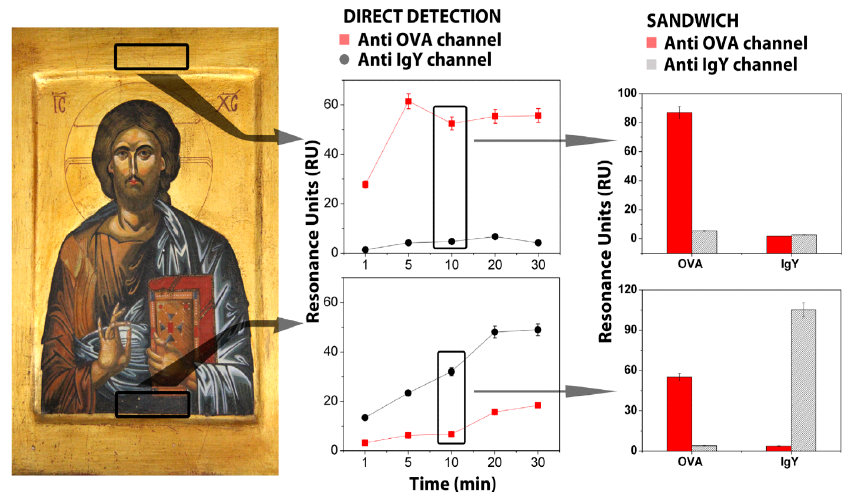
Figure 12. Original sample to test biosensor (left). In the center, SPR-biosensor data relative to Highly Viscous Polymeric Dispersion extracts from the gilded and painted zone. The graphs to the right show the processed data. Reproduced and reprinted with permission from [22].